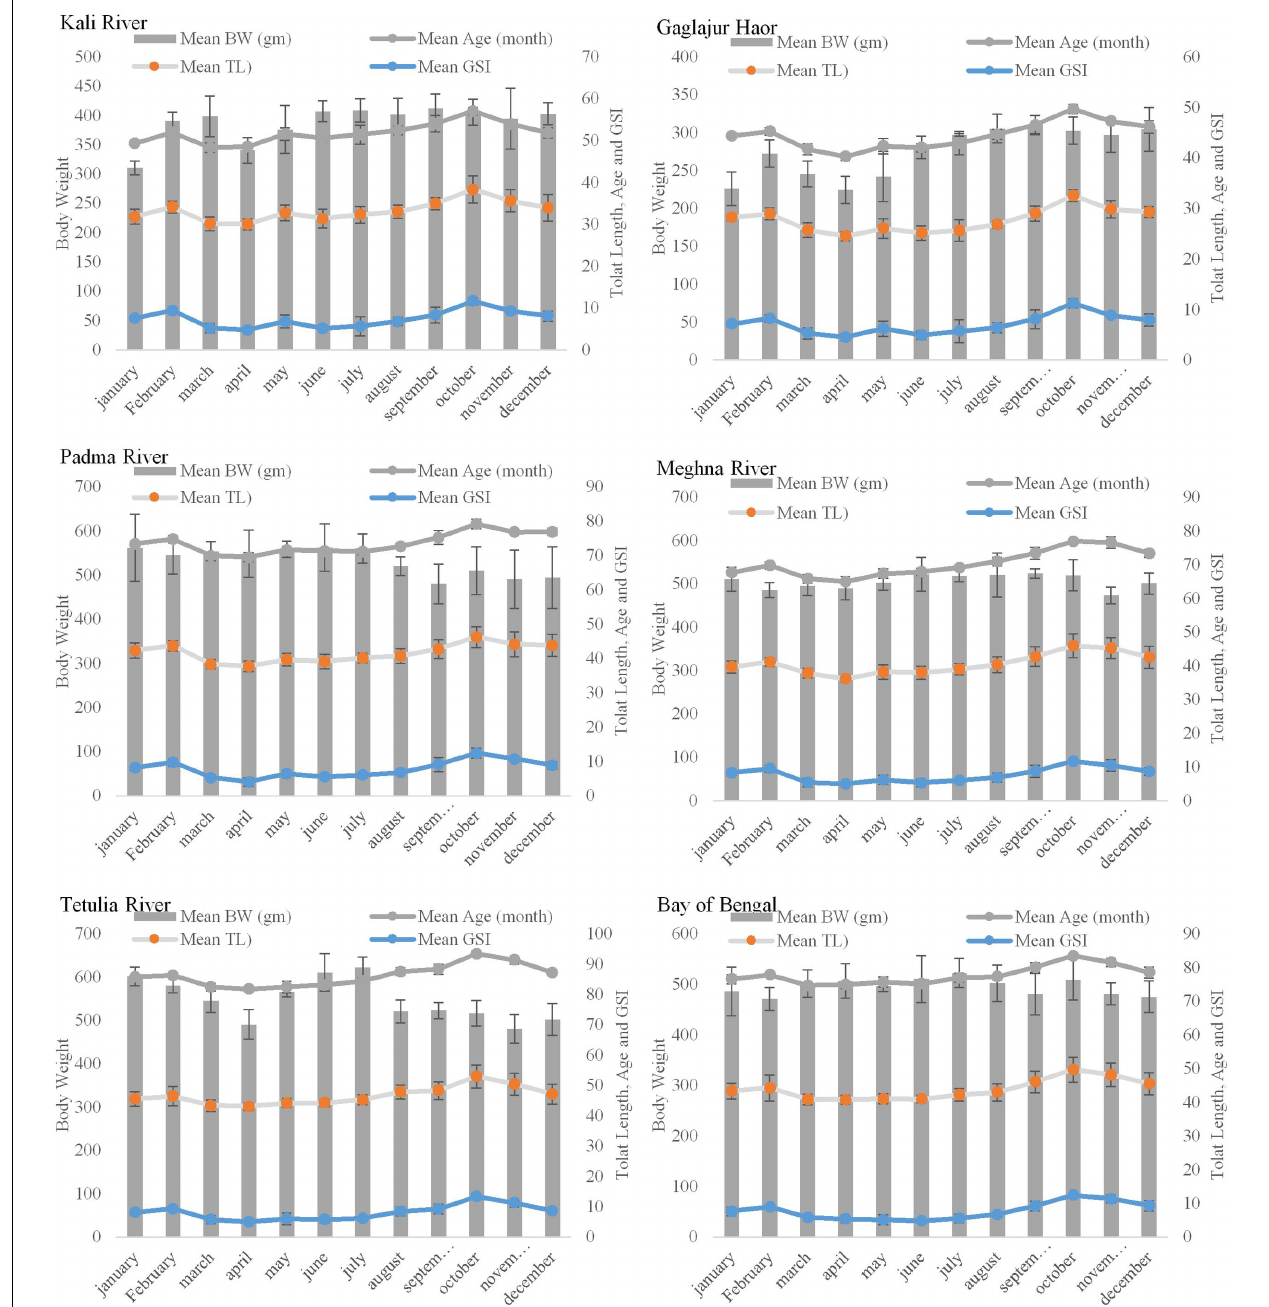
FIGURE 3 | Monthly variation of GSI in respect to the body weight of Hilsa in six different habitats.